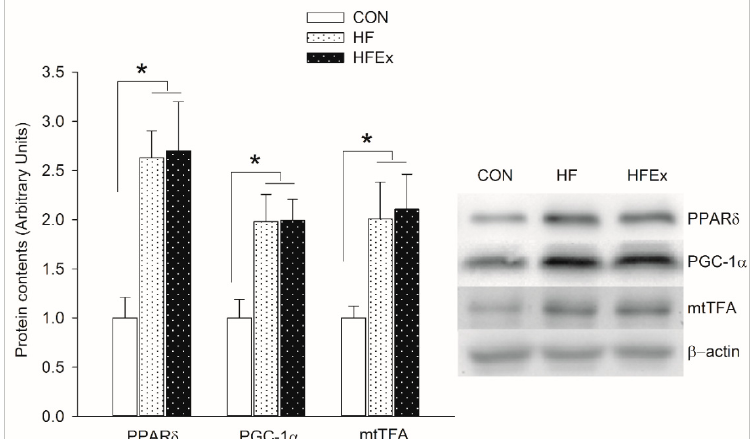
Figure 2. Expression levels of protein involved in mitochondrial biogenesis in the extensor digitorum longus (EDL) muscle. Data are presented as means ± SEM. Data was analyzed by one-way ANOVA. * p < 0.05. CON, control; HF, HFD intake; HFEx, high-fat diet with low-intensity endurance exercise; EDL, extensor digitorum longus.